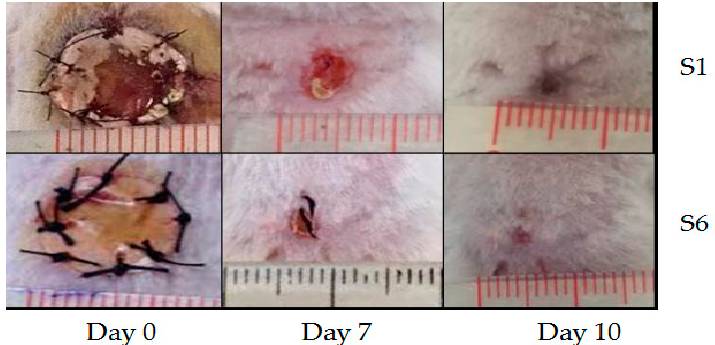
Figure 24. Photographs showing the contraction of dorsal wounds treated with S1 mat ( top panel ), and S6 mat ( bottom panel ) at day 0, day 7 and day 10, respectively. Reproduced with permission from [149]. Copyright Elsevier, 2018.